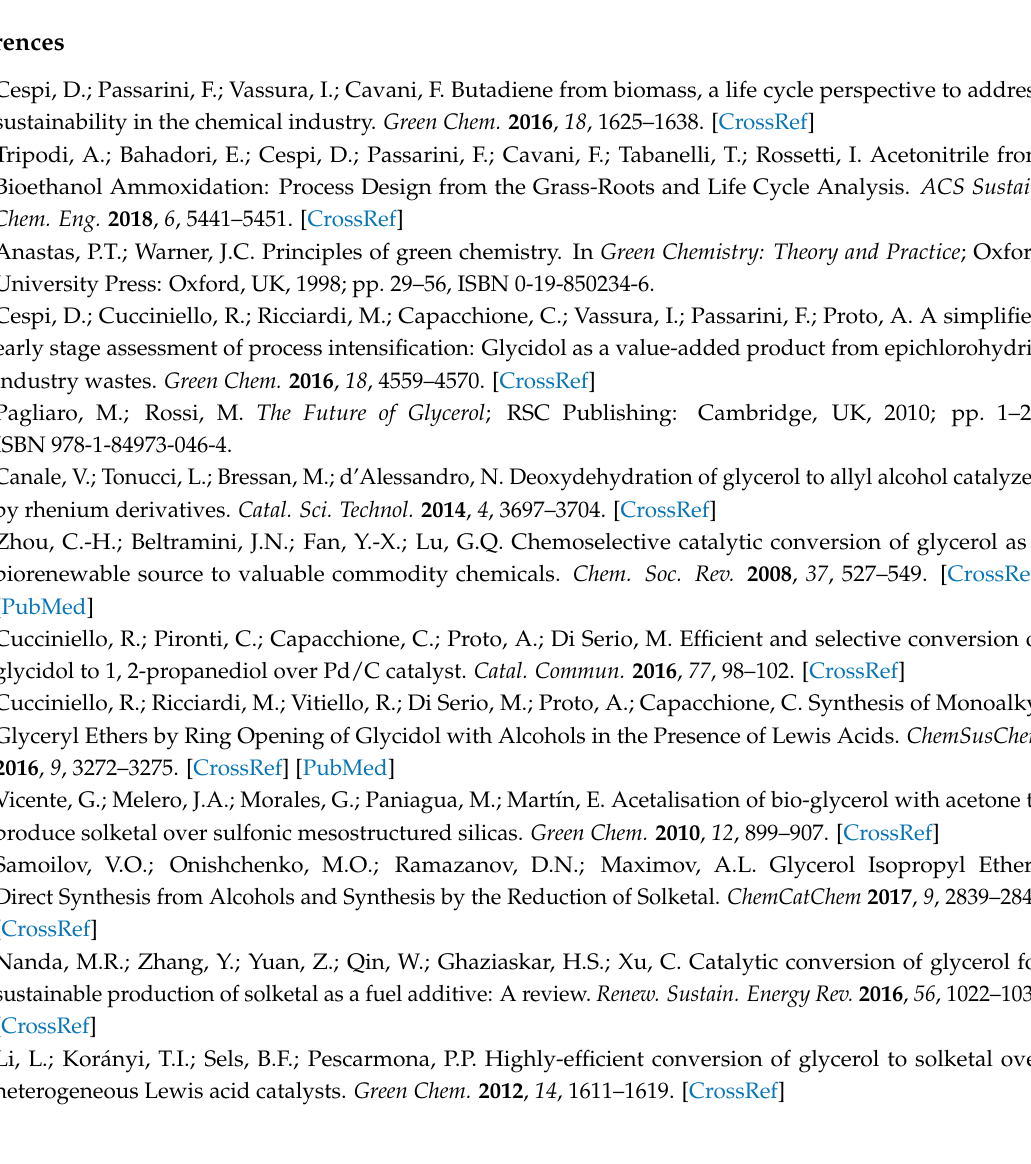
Figure S1. Nafion NR50 recyclability. Figure S2. 1H-NMR (CDCl3, 400 MHz) spectrum of reaction mixture. Figure S3. 13C-NMR (CDCl3, 100 MHz) spectrum of reaction mixture. Figure S4. Mechanistic pathways investigated and corresponding free energies (kcal/mol in acetone) for the sulfonated-silica catalyzed reaction. Table S1. Glycidol conversion to solketal. Scheme S1. Nafion NR 50 modeled structure. Scheme S2. Sulfonated-silica modelled